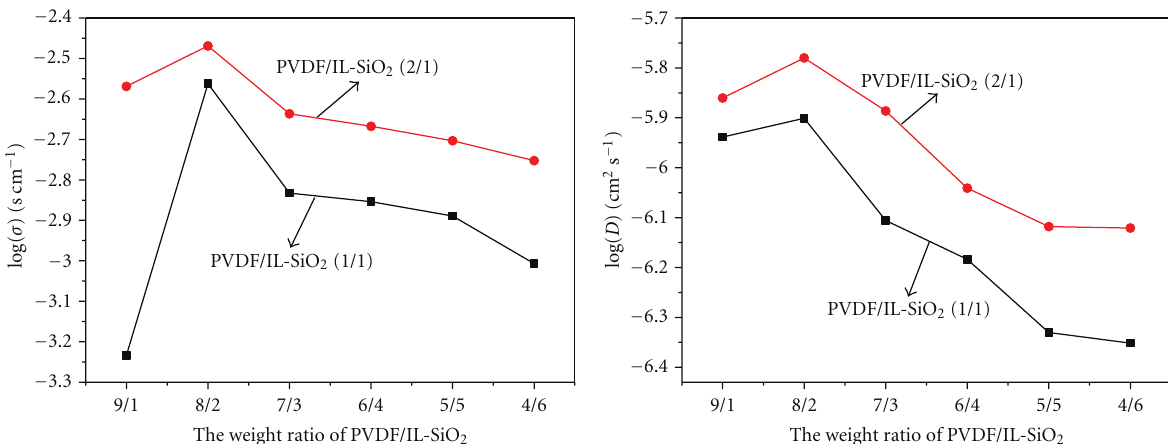
Figure 7: The ionic conductivity ( σ ) and the apparent di ff usion coe ffi cient of triiodide ( D ) of